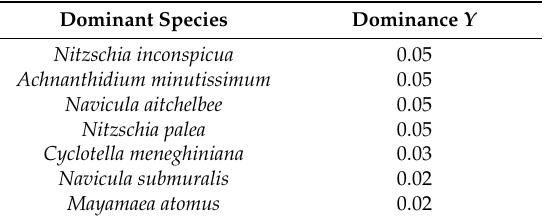
Table 1. Dominant species and dominance of benthic diatoms in the Ying River.